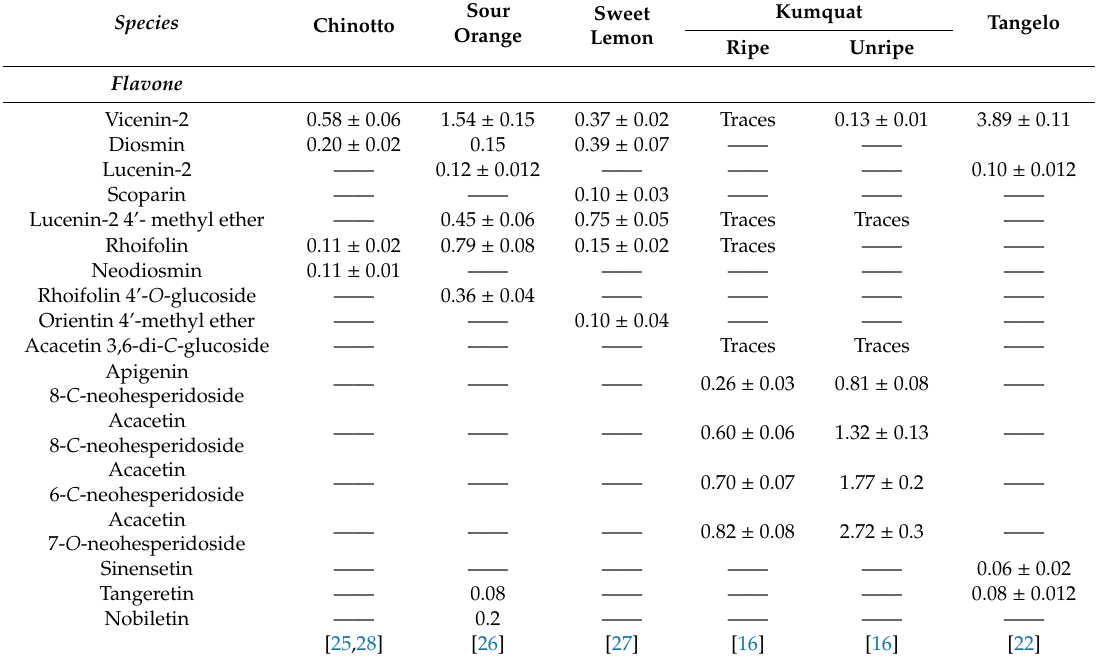
Table 4. Flavone content in chinotto ( Citrus myrtifolia Raf.), sour orange ( Citrus aurantium L.), sweet lemon ( Citrus limetta Risso), kumquat ( Fortunella japonica Swingle), and tangelo ( Citrus reticulata × Citrus paradisi ).